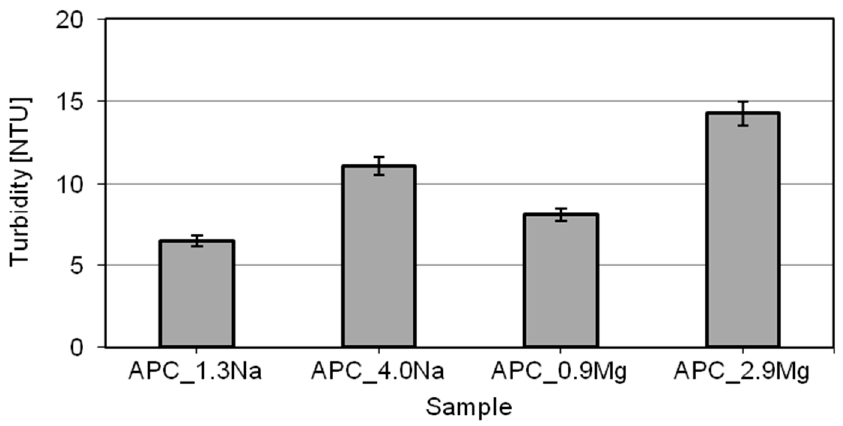
Figure 2. Turbidity of all-purpose